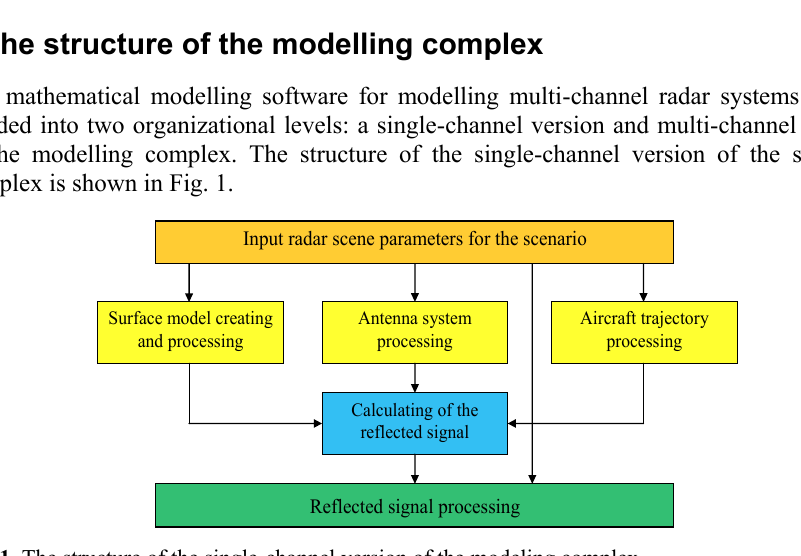
Fig. 1. The structure of the single-channel version of the modeling complex.